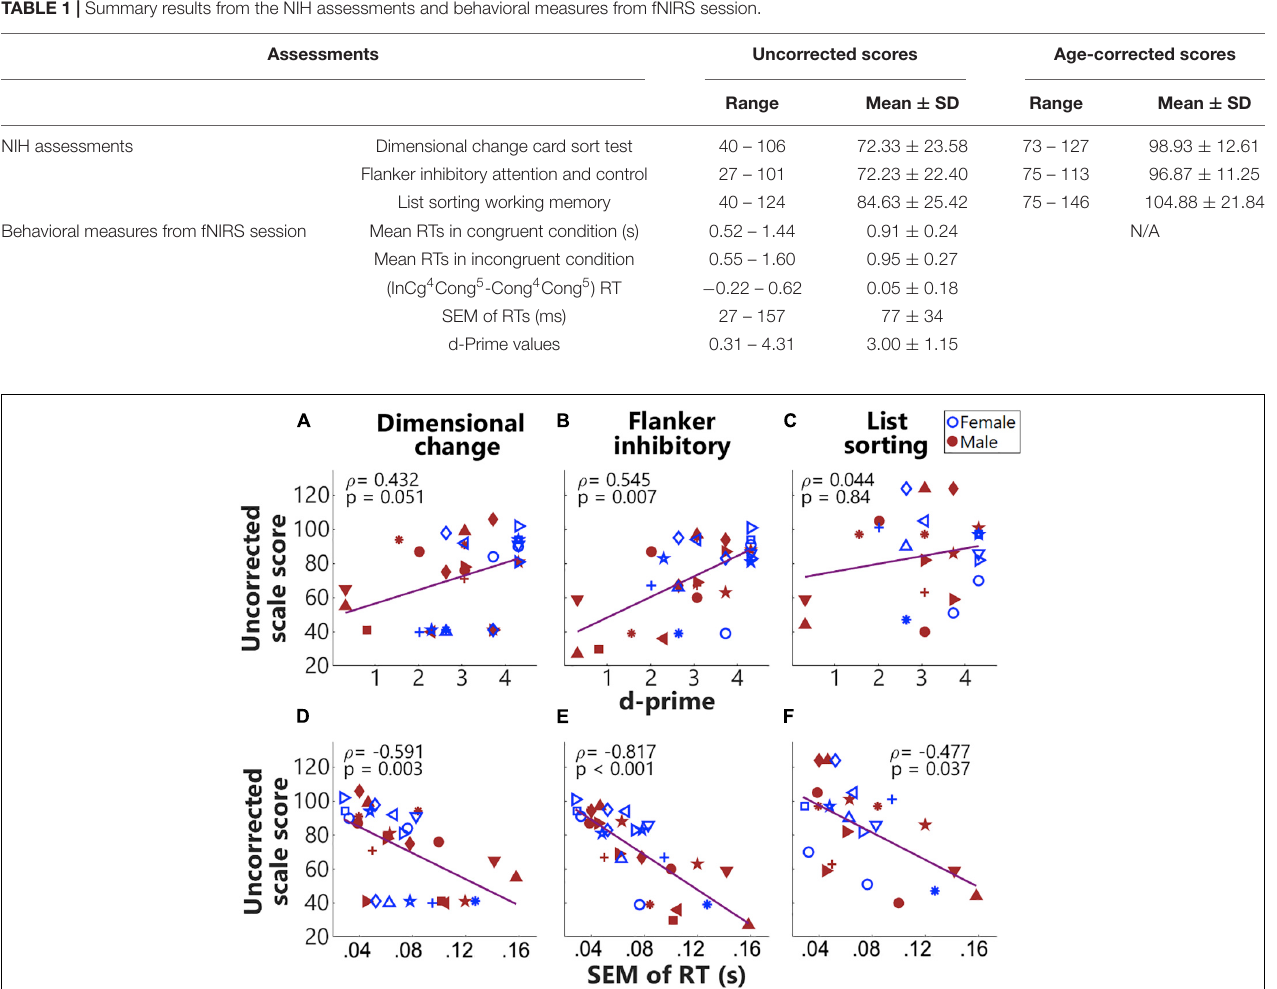
TABLE 1 | Summary results from the NIH assessments and behavioral measures from fNIRS session.